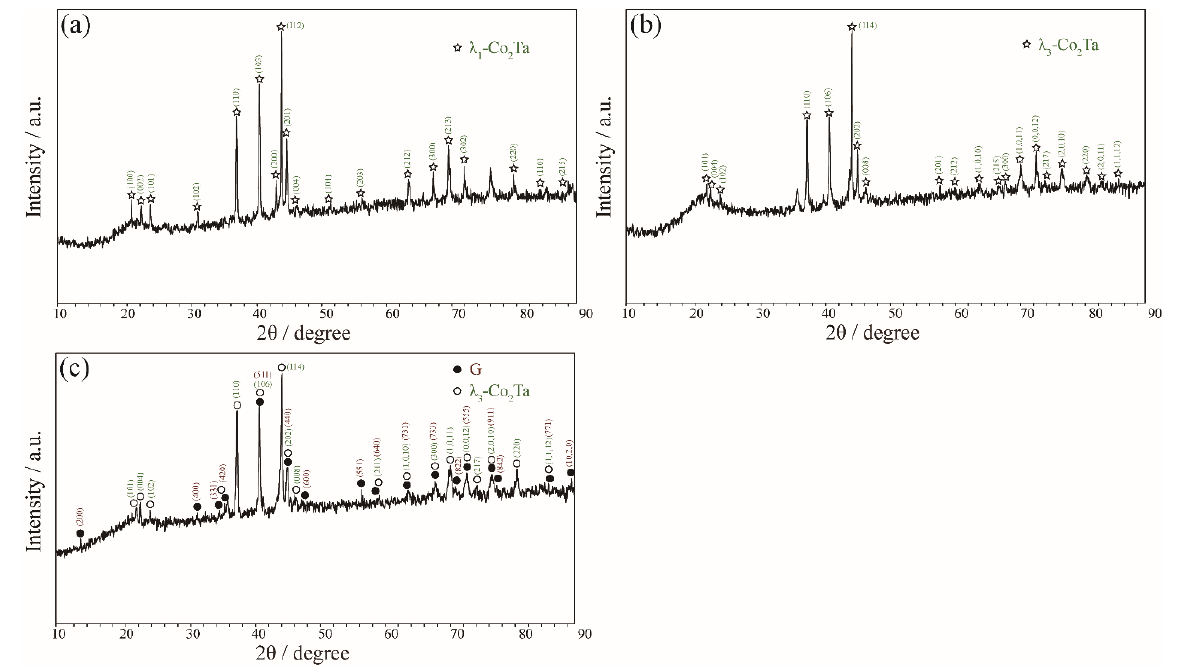
Figure 9. XRD patterns obtained of ( a ) Co 59 Ta 31 Si 10 alloy annealed at 1100 ◦ C for 60 days; ( b ) Co 65 Ta 27 Si 8 alloy annealed at 1100 ◦ C for 60 days and ( c ) Co 65 Ta 27 Si 8 alloy annealed at 900 ◦ C for 90